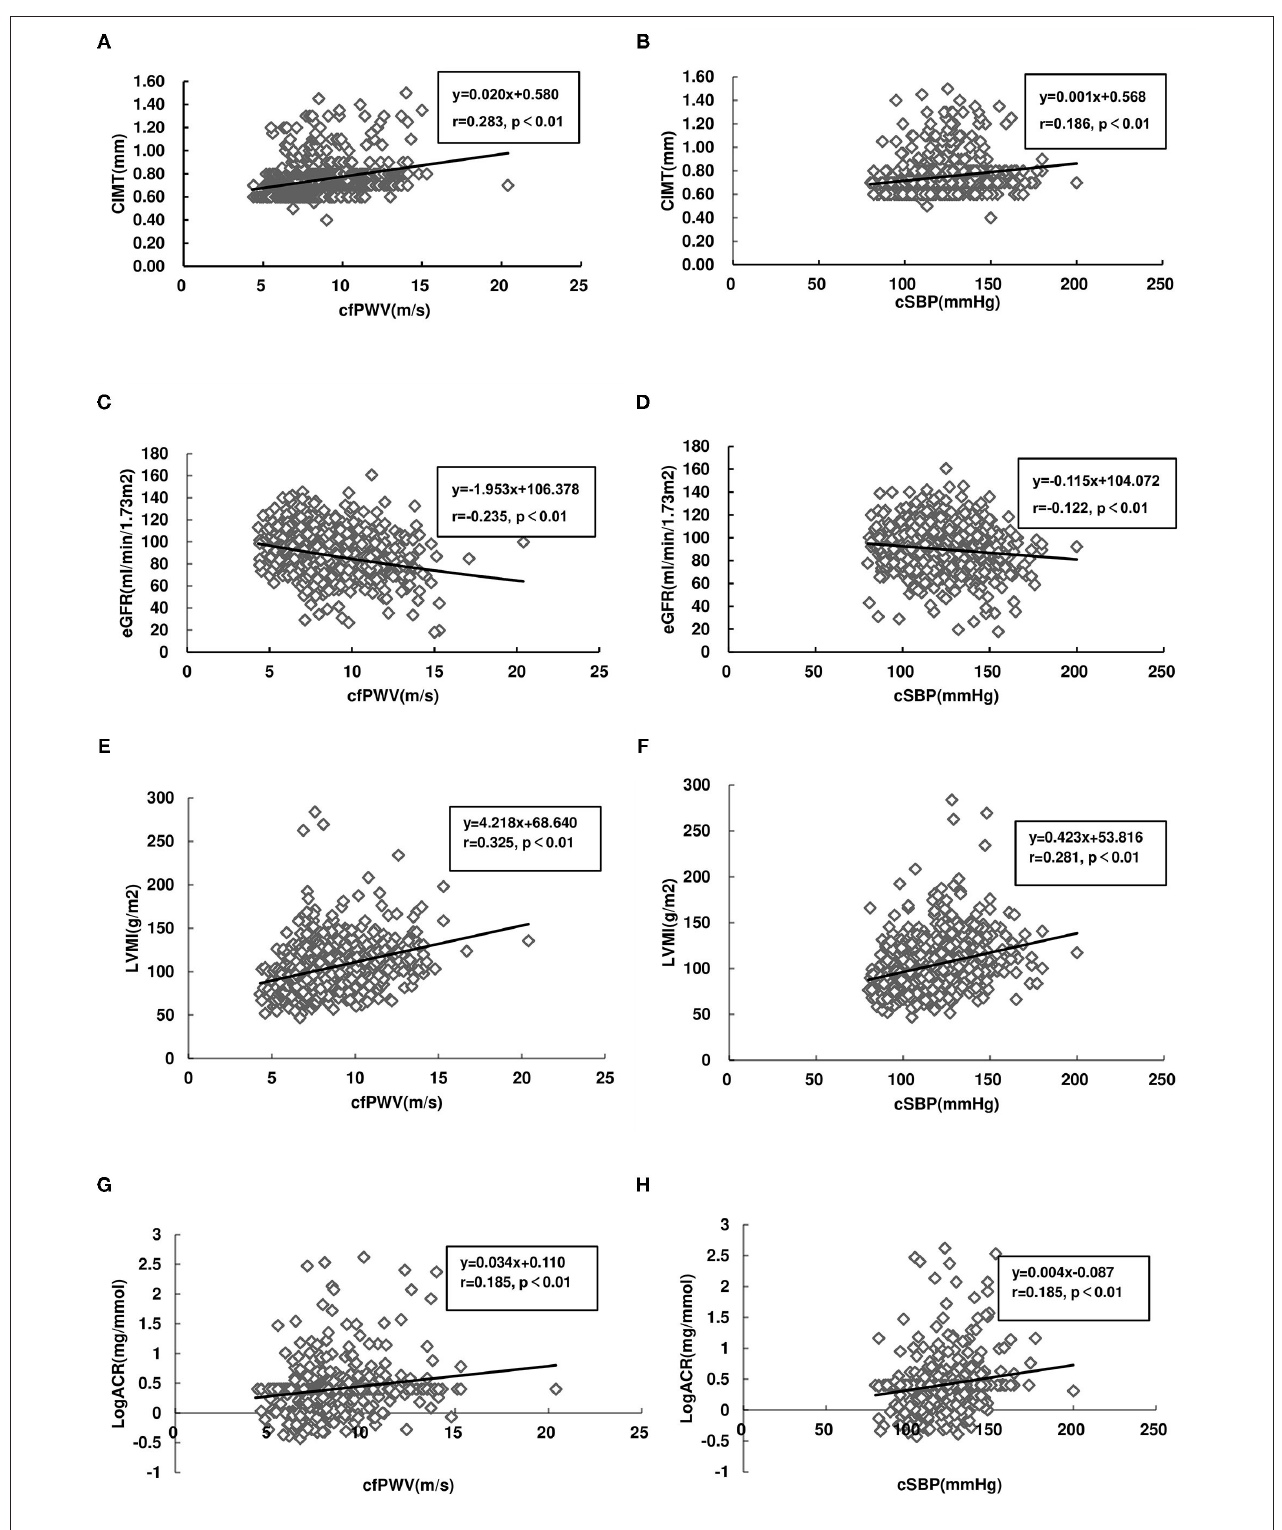
FIGURE 1 | Correlations between target organ damage (TOD) and carotid-femoral pulse wave velocity (cfPWV), as well as central systolic blood pressure (cSBP), carotid intima-media thickness (CIMT), and cfPWV (A) ; CIMT and cSBP (B) ; estimated glomerular filtration rate (eGFR) and cfPWV (C) ; eGFR and cSBP (D) ; left ventricular mass index (LVMI) and cfPWV (E) ; LVMI and cSBP (F) ; Log (urinary albumin-creatinine ratio, ACR) (LogACR) and cfPWV (G) ; and LogACR and cSBP (H) . Linear regression lines for (x) and (y) variables are shown with correlation coefficients and P -values.